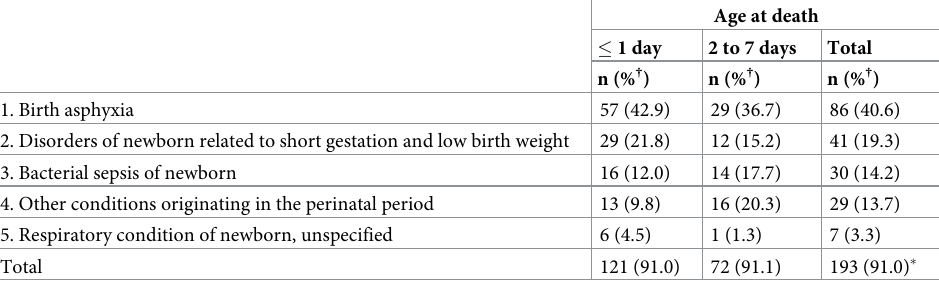
Table 2. Top five causes of neonatal death identified using PN RAPID in two facilities in Liberia.